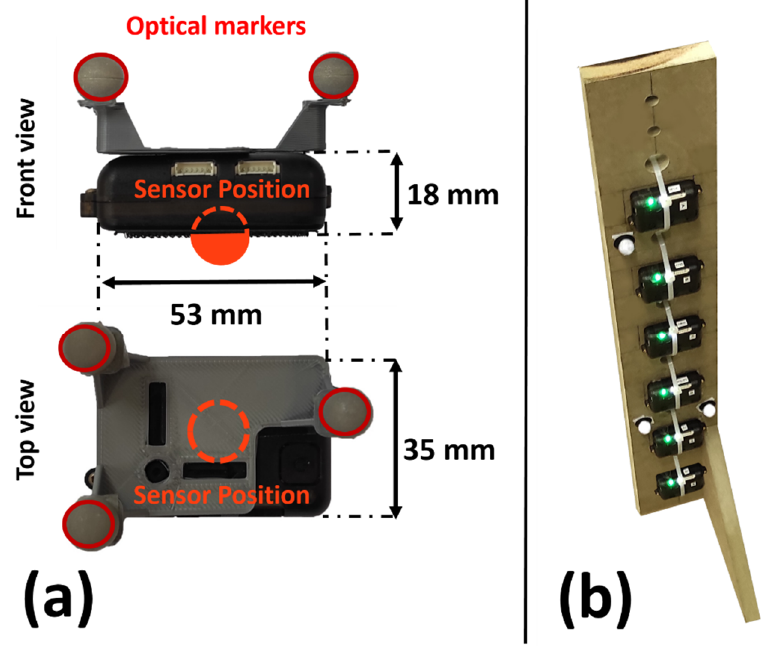
Figure 3. ( a ) IMU dimensions and marker attachment; ( b ) Wooden plate for calibration of the inertial sensors.